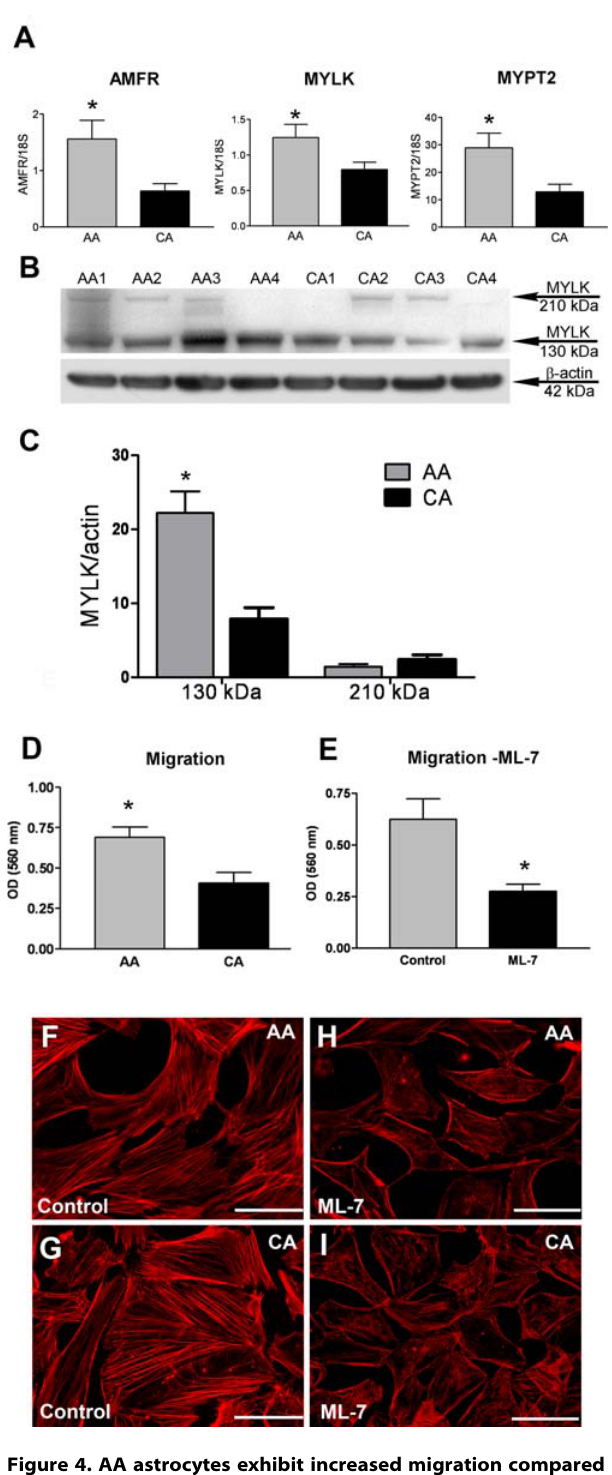
Figure 4. AA astrocytes exhibit increased migration compared to CA astrocytes. A. Confirmation of three differentially expressed motility genes by qRT-PCR in human normal ONH astrocytes: autocrine motility factor receptor (AMFR), myosin light chain kinase (MYLK) and myosin phosphatase target subunit 2 (MYPT2). Genes were normalized to 18S. Graphical representation of the relative mRNA levels in AA and CA astrocytes (n=8, respectively, * indicates p , 0.05 in two-tailed t- test). B. Representative Western blots of astrocyte cell lysates with MYLK antibody. b -actin was used as a loading control. Note that AA1-4 donors express more MYLK 130 kDa than CA1-4 donors. No